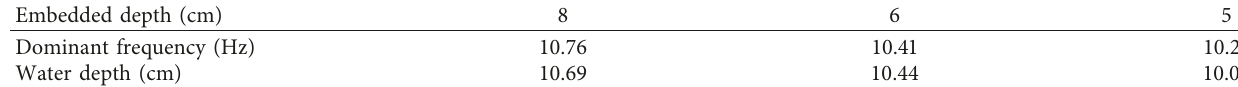
Table 1: Dominant frequency and embedded depth selected from the scaled scour